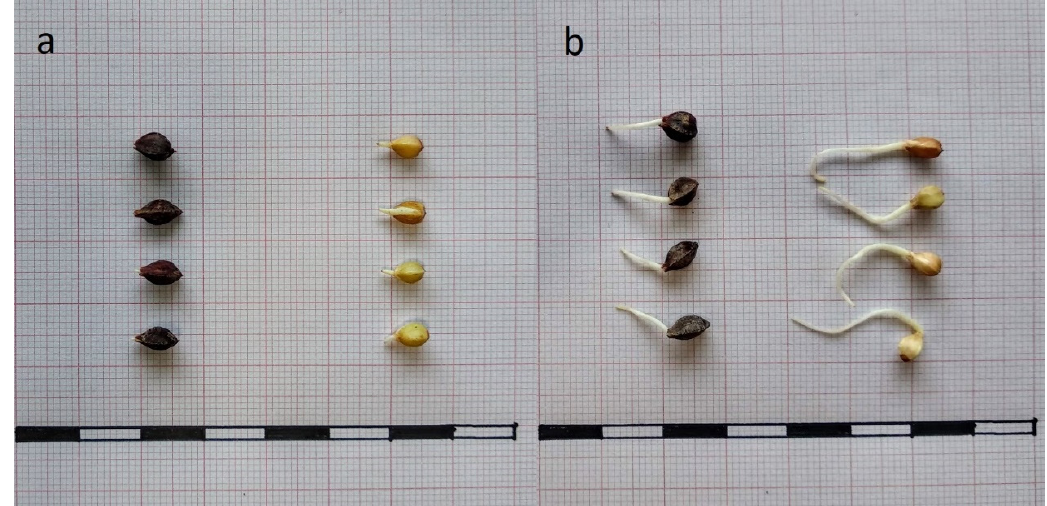
Figure 2. Germinated of representative hulled (left) and dehulled (right) buckwheat seeds after 24 h ( a ) and 48 h ( b ) of germination. Scale measures, 1.0 cm.